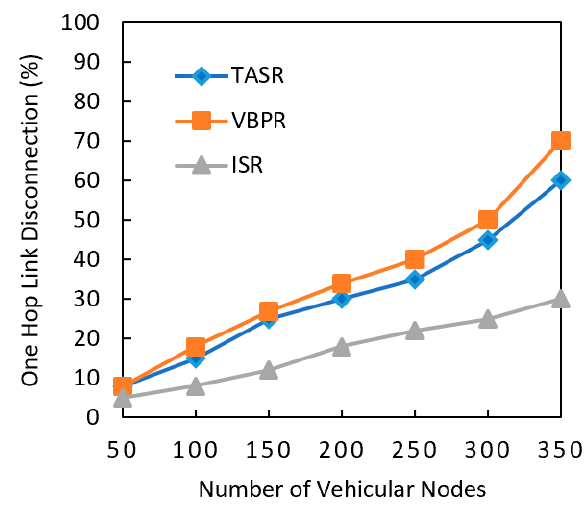
Figure 8. Comparison of one-hop link disconnection with increasing number of nodes.